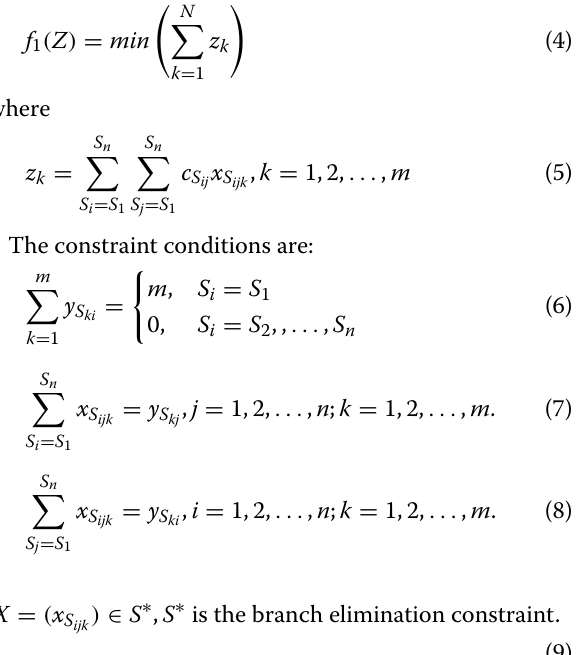
as follows: (1) any travelling city (segment) is no longer regarded as an abstract point (data acquisition position) but is a set of points. (2) Different travelling salesmen (MDCs) set out and return to the same city, which is the source city, but may in fact correspond to different points in the city. (3) The source city needs to be speci- fied, and the starting and ending points are the same for the same travelling salesman but may be different for dif- ferent travelling salesmen. As shown in Fig. 1, the moving path of one MDC is S 1 − S 2 − S 3 − S 4 − S 7 − S 1